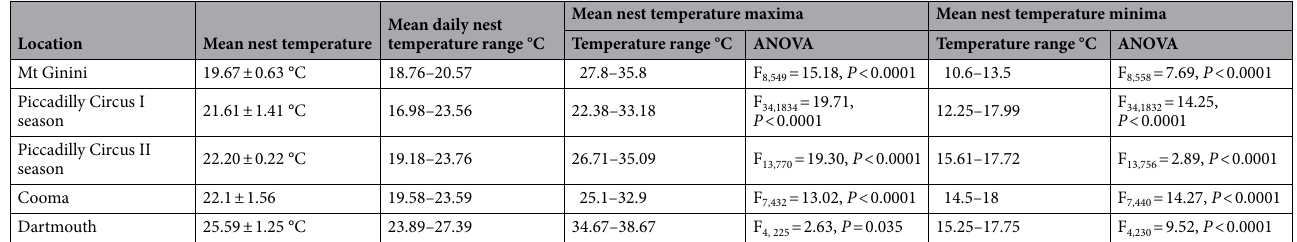
Table 1. Descriptors of nest temperatures of B. duperreyi in four locations. Nest temperature data were continuous temperatures taken by data loggers at one-hour intervals throughout incubation (9 weeks in Mt Ginini, Piccadilly Circus, Cooma) (7 weeks in